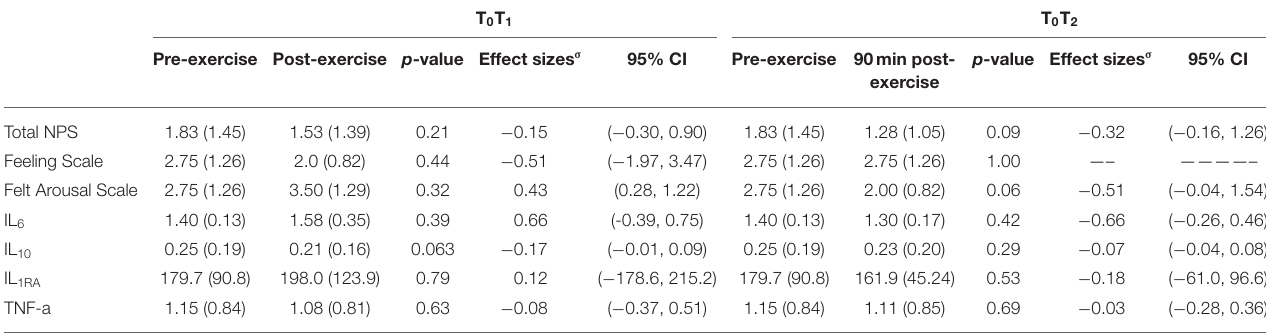
TABLE 4 | Changes in the study outcome measures among persons with paraplegia ( n = 4).